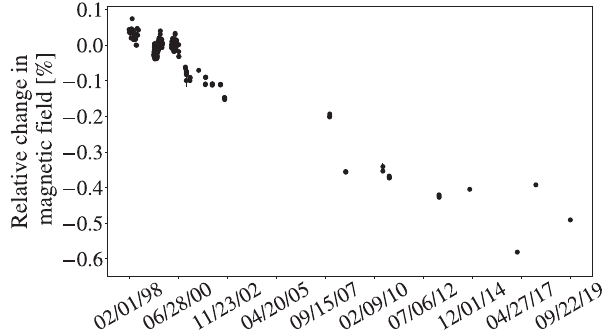
FIG. 14. The relative magnetic field strength of a Recycler style permanent magnet over